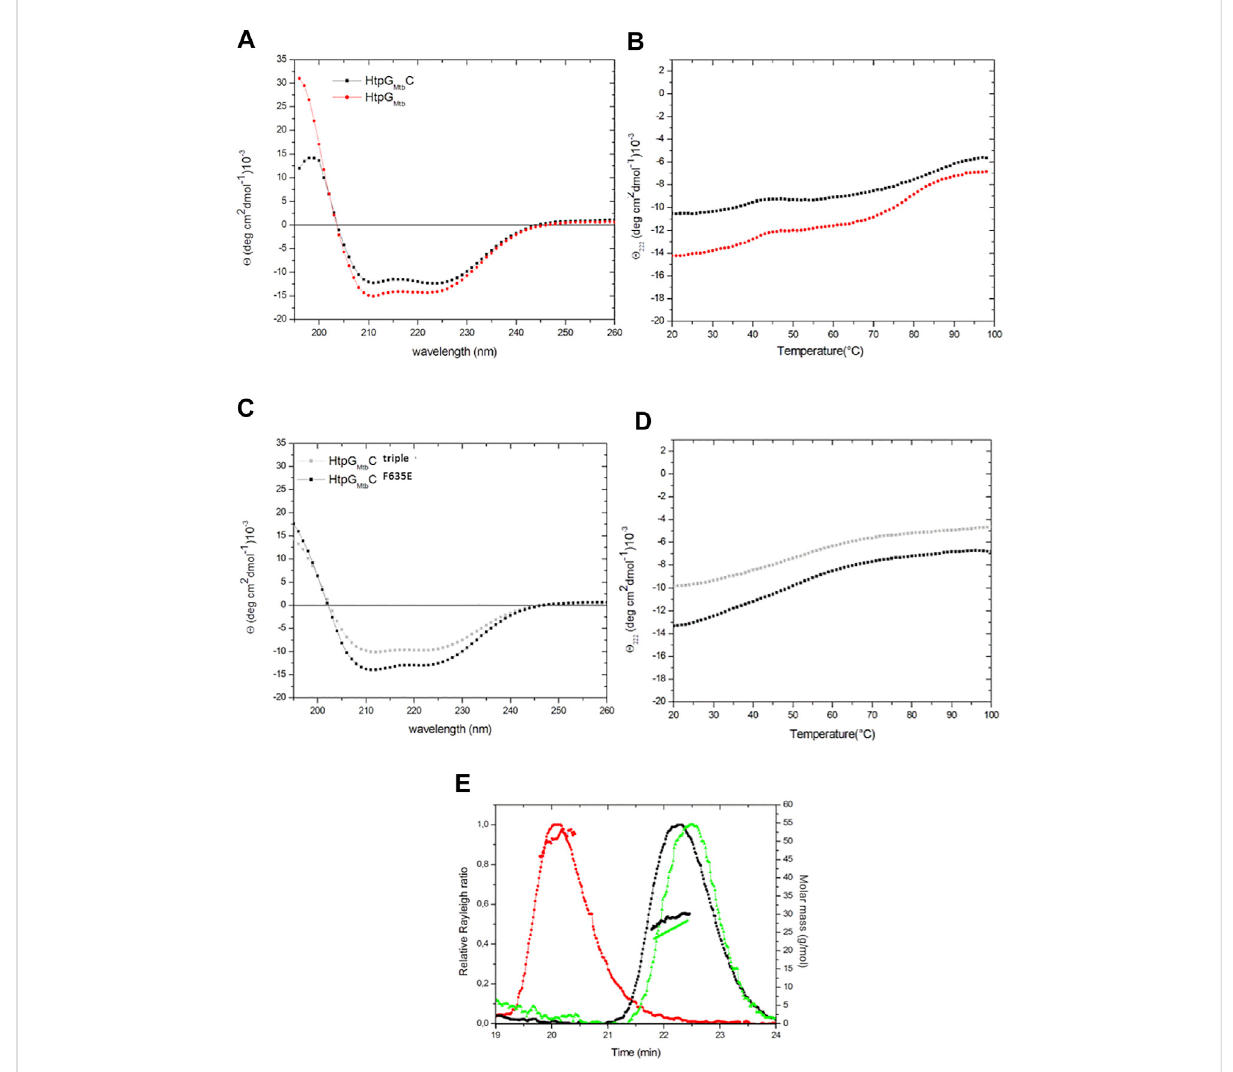
FIGURE 4 Superposition of CD spectra (A) and thermal unfolding at 222 nm (B) of HtpG Mtb and HtpG Mtb _C, measured in 20 mM sodium phosphate (pH 7.4). (C) Superposition of CD spectra and (D) thermal unfolding at 222 nm of HtpG Mtb _C mutants in 20 mM sodium phosphate (pH 7.4).